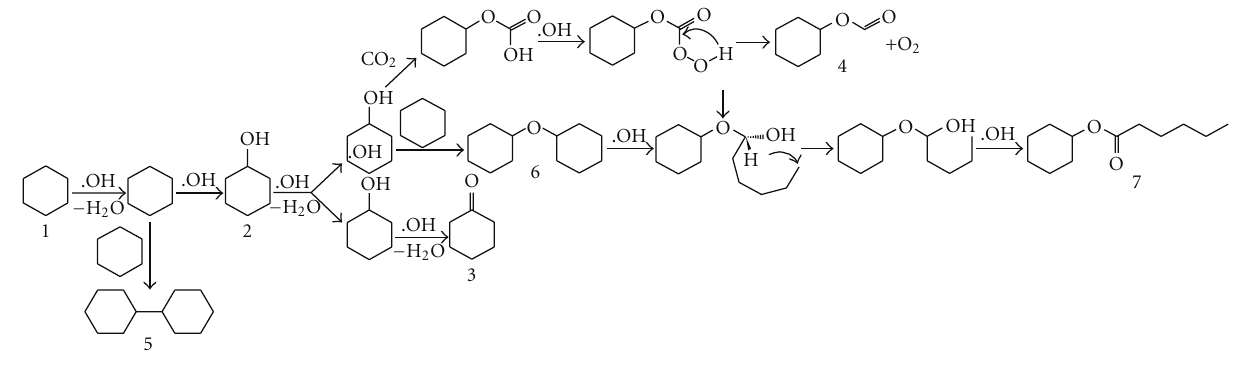
Scheme 1: Mechanism for the degradation of cyclohexane in PCO. Table 1: Property and ultimate analyses of DVR.